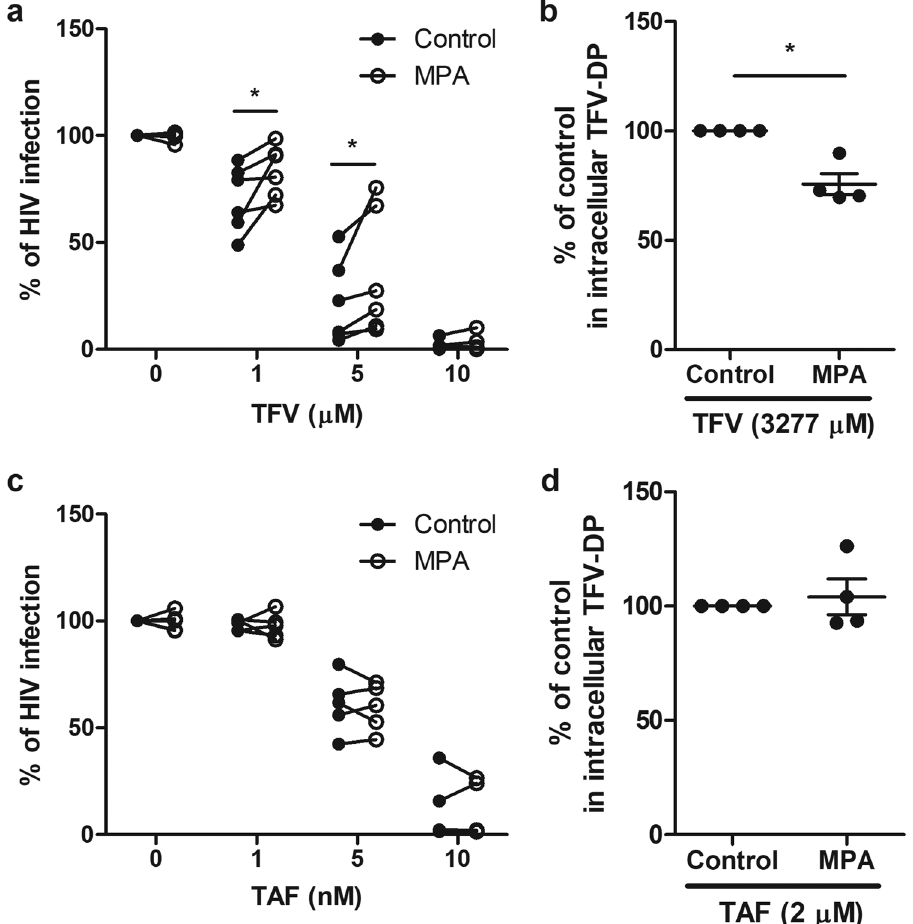
Figure 3. Effect of MPA on TFV and TAF inhibition of HIV infection and intracellular TFV-DP of blood CD4 + T cells. ( a and c ) Activated blood CD4 + T cells were pre-treated with indicated doses of TFV or TAF for 24hr and inoculated with HIV for 2hr. Following washout of virus after 2hr of culture, cells were incubated with MPA (1 × 10 − 7 M) at 5 days following infection, after which levels of p24 released in the culture media was measured by p24 enzyme-linked immunosorbent assay. Data were normalized to % of HIV infection with respect to infected controls without TFV or TAF pre-treatment and in the absence of MPA. ( a ) Percent of HIV infection on TFV treatment from 6 individual blood donors. ( c ) Percent of HIV infection on TAF treatment from 5 individual blood donors. Dark circles represent culture media in the absence of MPA and open circles represent culture media in the presence of MPA. Each circle represents one individual donor. * p < 0.05. ( b and d ) TFV-DP levels were measured by LC-MS/MS in purified blood CD4 + T cells pre-treated with MPA (1 × 10 − 7 M) for 24 hr followed by incubation with ( b ) TFV (3277 µ M) and ( d ) TAF (2 µ M) for an additional 24hr. Data were normalized to % fold change from control values. The bar represents the mean and SEM from 4 individual blood donors. Each circle represents one individual donor. * p <